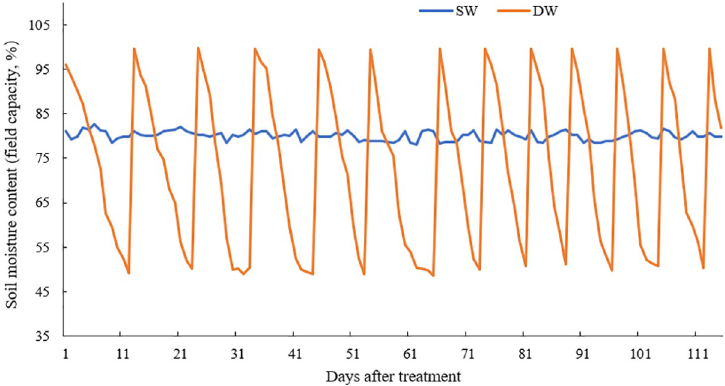
Fig 1. Soil water percentage in field capacity under different treatments. SW is the treatment for stable soil moisture content, and DW is the alternate dry and wet treatment.